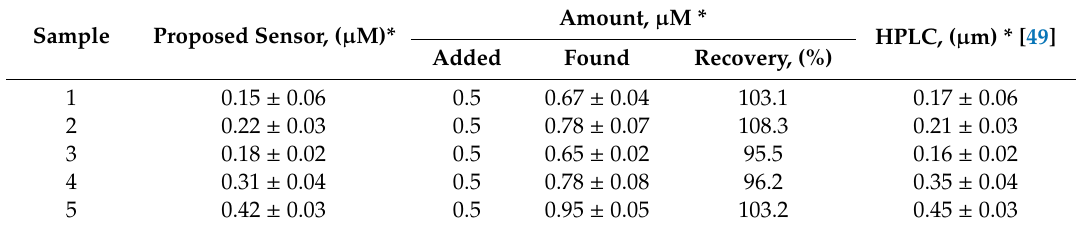
Table 2. Application of the proposed sensor to determination of DCP in the water samples.